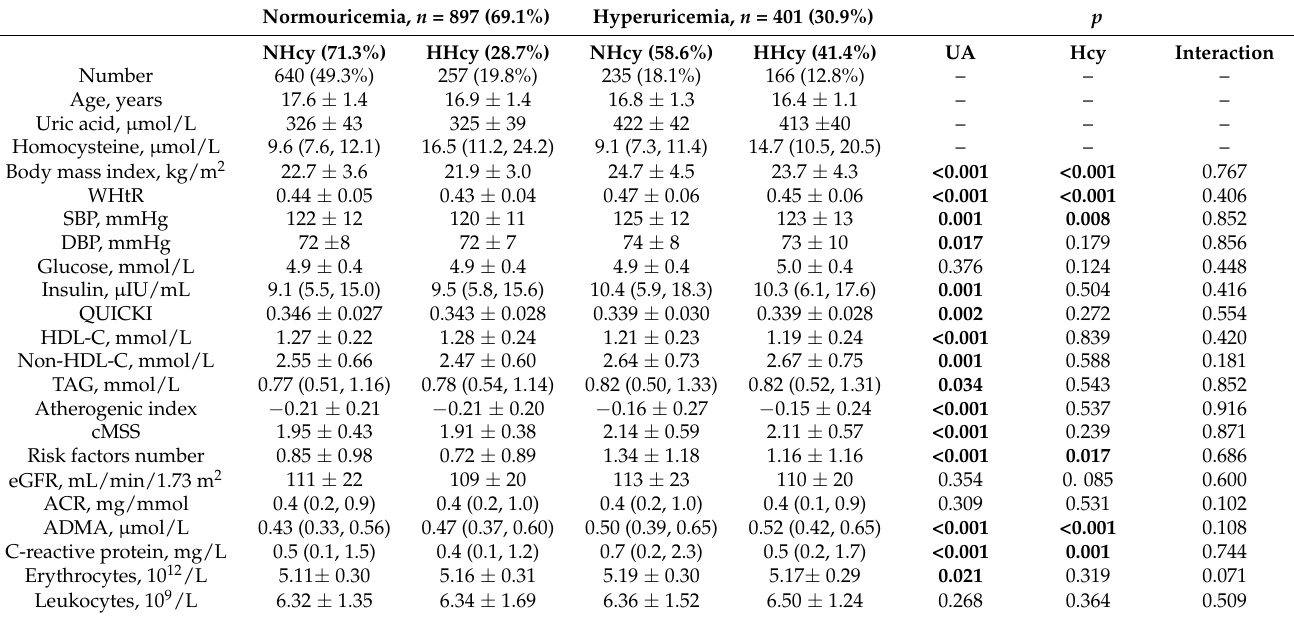
Table 3. Characteristics of males according to uricemia and homocysteinemia.